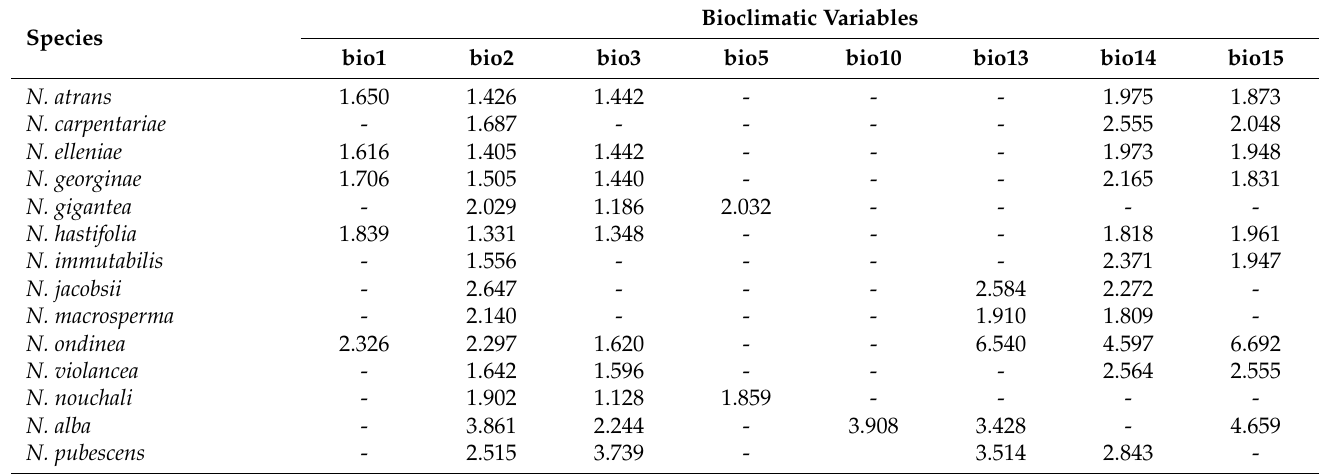
Table 1. Climatic variables were retained after eliminating the correlation using variance inflation factors (VIFs).